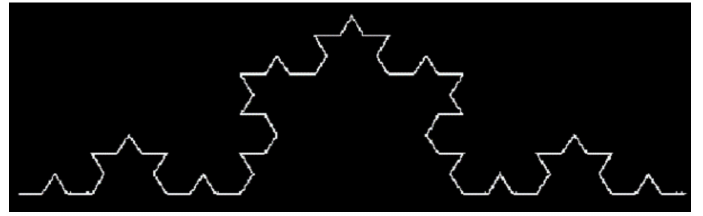
Figure 2. Inverse Koch curve.